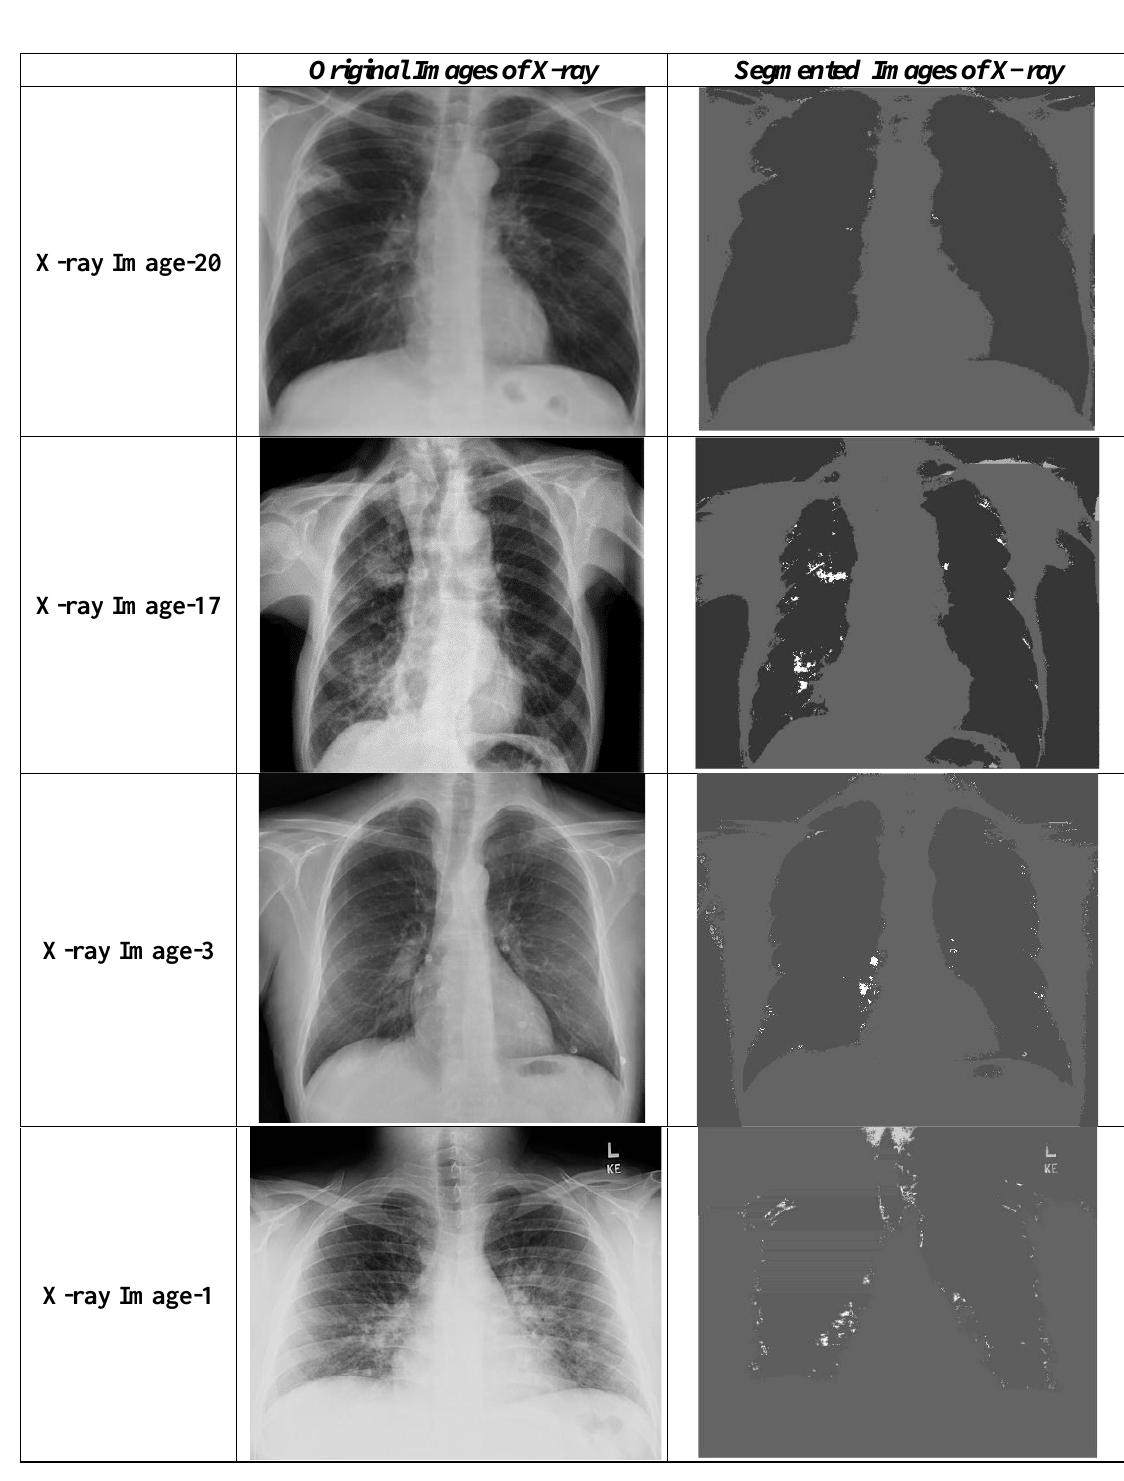
Figure 3. Original and segmented images with white